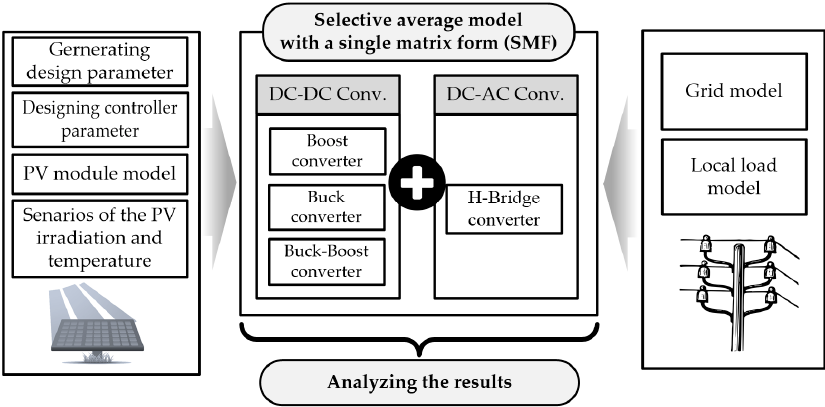
Figure 3. Proposed modeling approach for the multiple microinverters system.